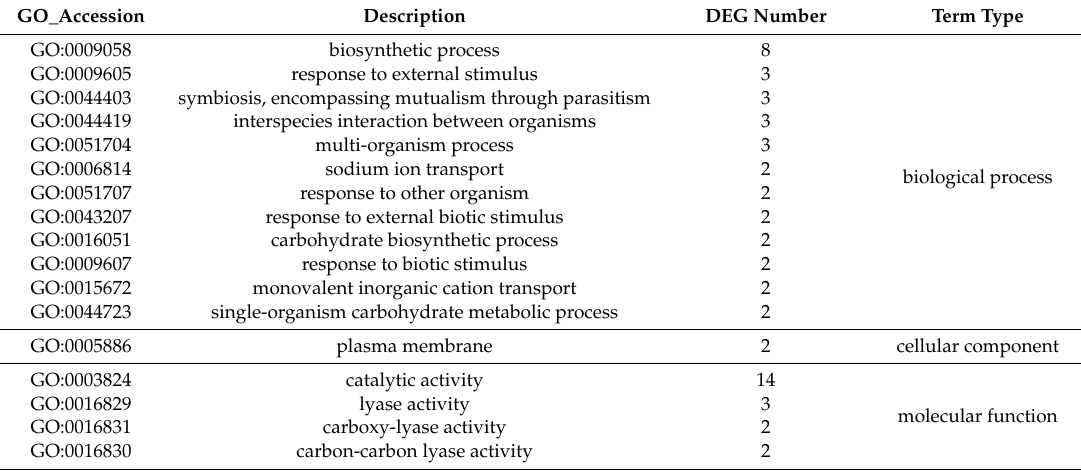
Table 2. GO enrichments of downregulated